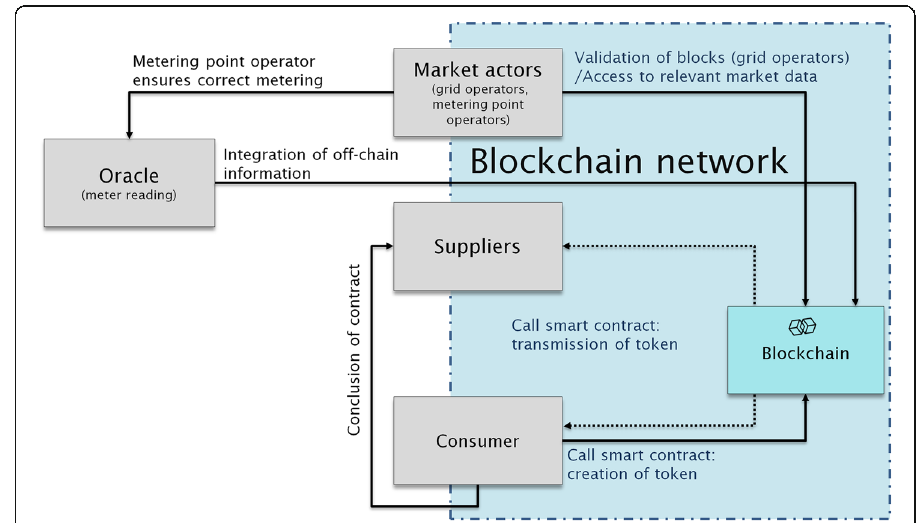
Fig. 1 Schematic representation of a token-based